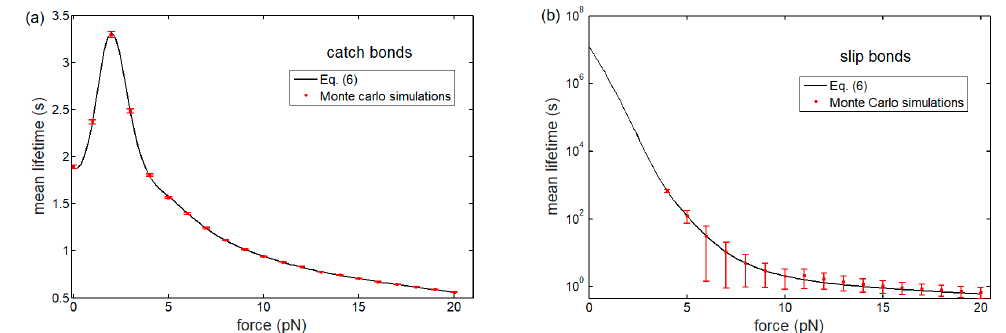
Figure 5. Mean lifetime of bond clusters as a function of interfacial force with N t = 10 for ( a ) catch and ( b ) slip bonds. The theoretical results (solid curves) are in good agreement with the simulations (discrete symbols).